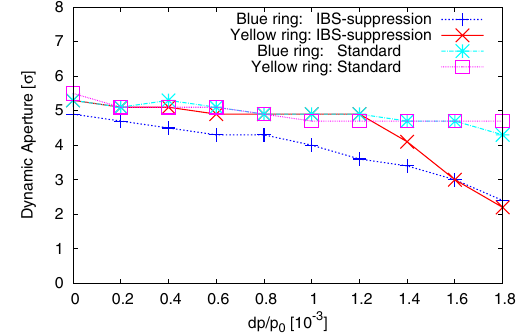
FIG. 8. Calculated off-momentum dynamic apertures for the IBS-suppression lattices and standard lattices. Second order chromaticity corrections are not included.